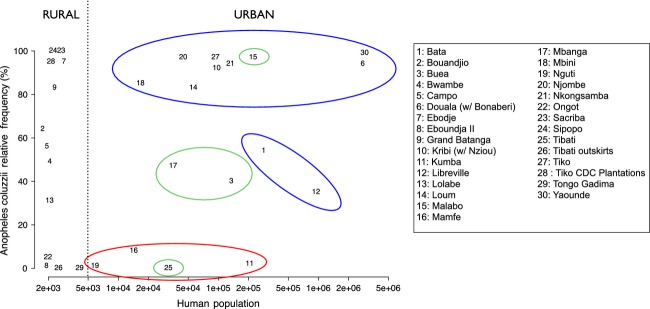
Relationship between the size of each locality shown in Fig.1B, expressed as number of inhabitants and the relative abundance of An. coluzzii and An. gambiae. Ellipses identify urban centres with respect to their position relative to the Cameroon Volcanic line (CVL): westwards (red), eastwards (blue) or on the CVL (green). On the opposite sides of the CVL, urban centres are dominated by one or the other of the two species, while localities on the CVL identify a ‘contact zone’. Exceptions to this pattern are Bata (N°1) and Malabo (N°15) in Equatorial Guinea, Libreville (N°12) in Gabon and Tibati (N°25) in Cameroon. The latter is situated on/east of the CVL, but it lies at >800 m altitude in the forest/savanna mosaic, outside of the rainforest ecozone. In Bata and Libreville, the two species are in apparent parapatry (data not shown). Malabo is on the island of Bioko, on the CVL, under the influence of insular biogeography (e.g. Deitz et al. 2012).